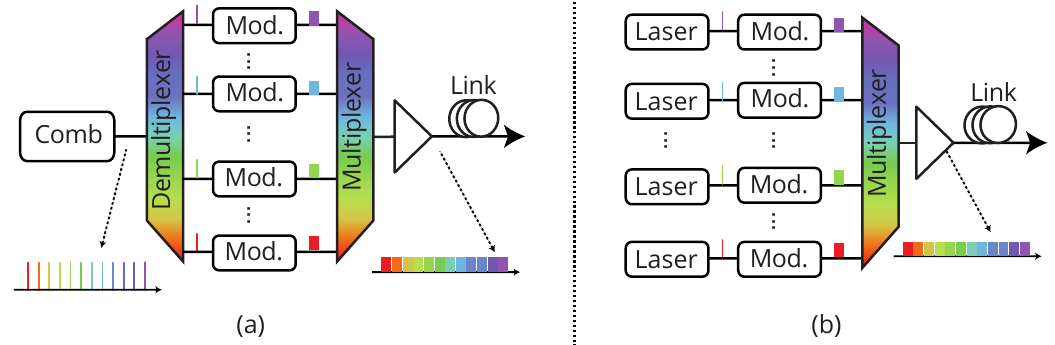
Figure 3. Schematic of ( a ) a comb-based transmitter and ( b ) a transmitter using a laser array. Mod.: